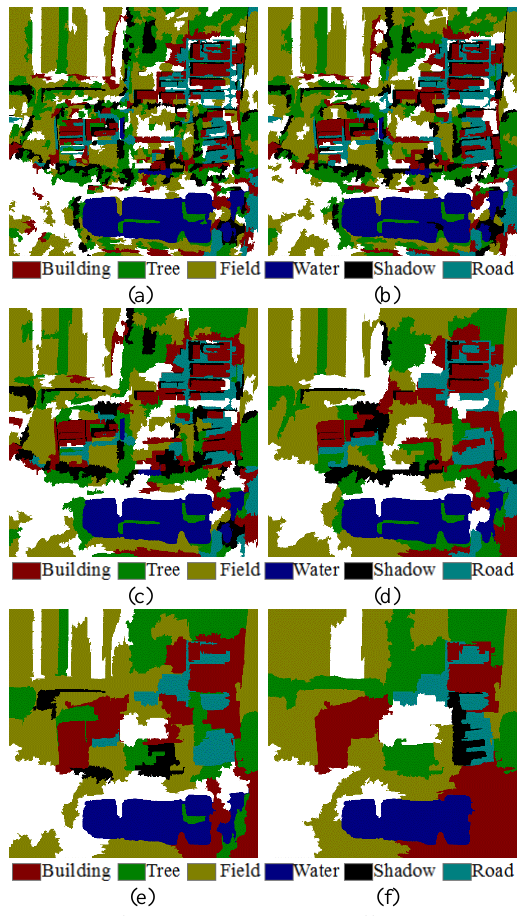
Figure 9. Classification results based on different segmentations (The number of segments for image segmentation is 1500, 1000, 500, 200, 100, and 50, respectively) Through comparing Figure 8 and Figure 9, e.g., Figure 8(b)